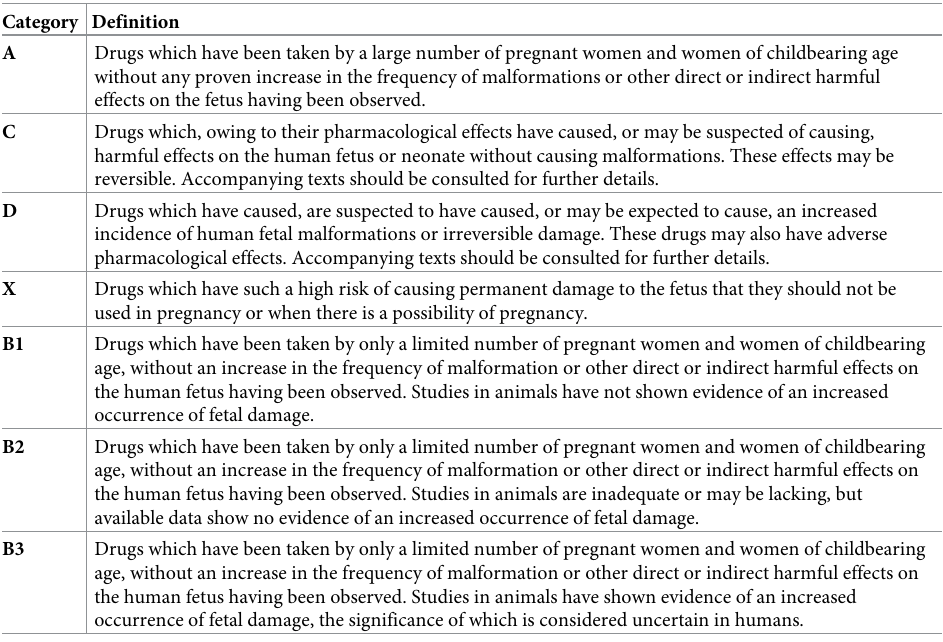
Table 1. Australian categorisation system for registered medicines in pregnancy TGA